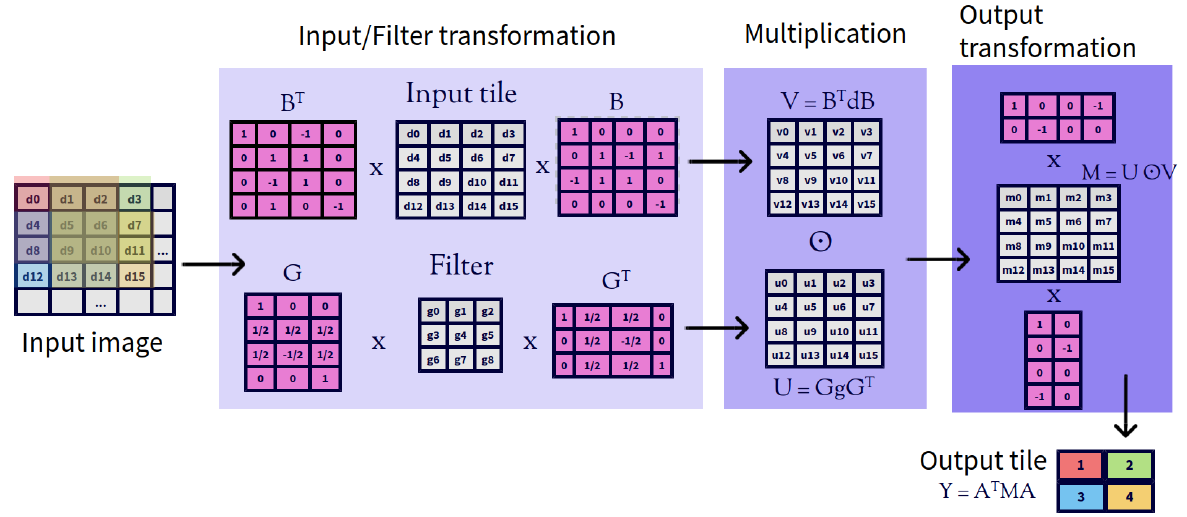
Figure 2. Winograd’s convolution in two dimensional